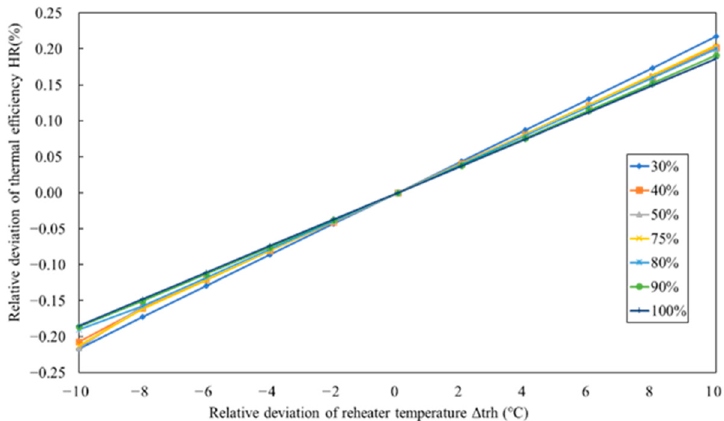
Figure 5. Variation in the relative deviation of thermal efficiency with reheated steam temperature disturbance under different output power loads.